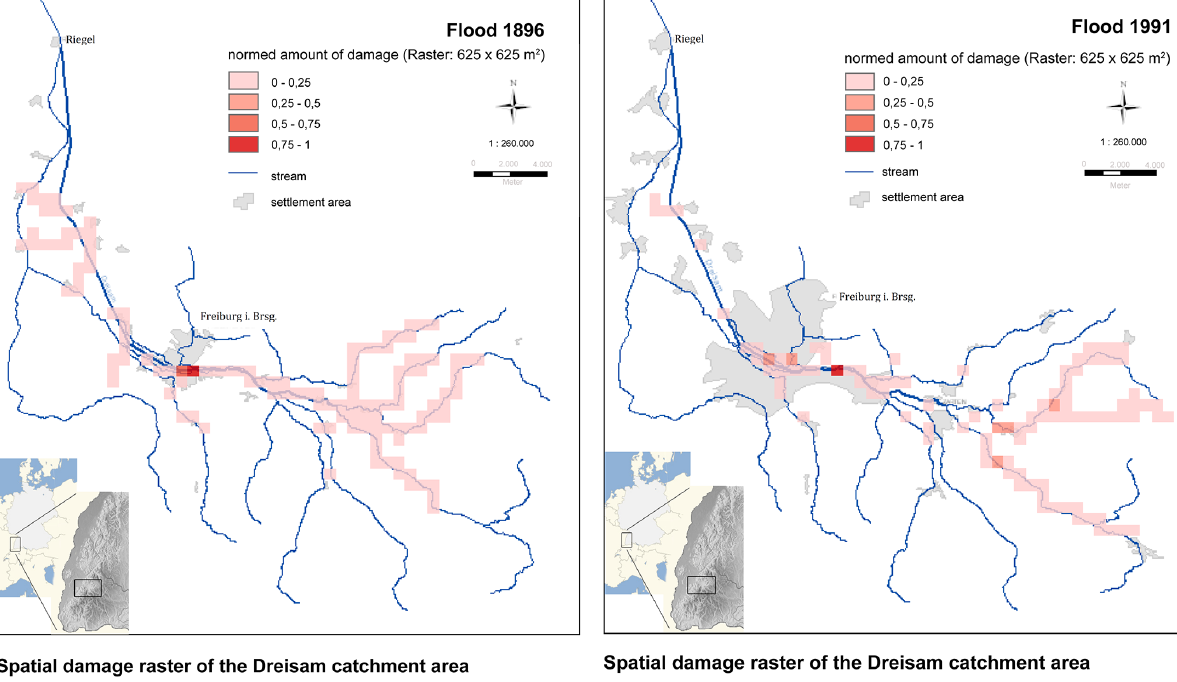
classes from “no damage” (white) to “high damage” (red) (Jeworutzki,